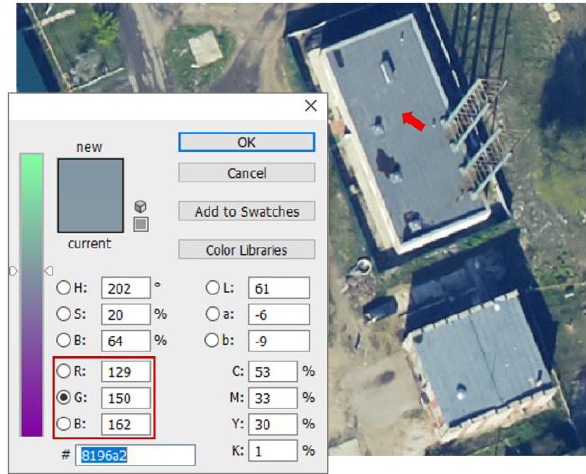
Figure 14. Color balance estimation manually by gray objects